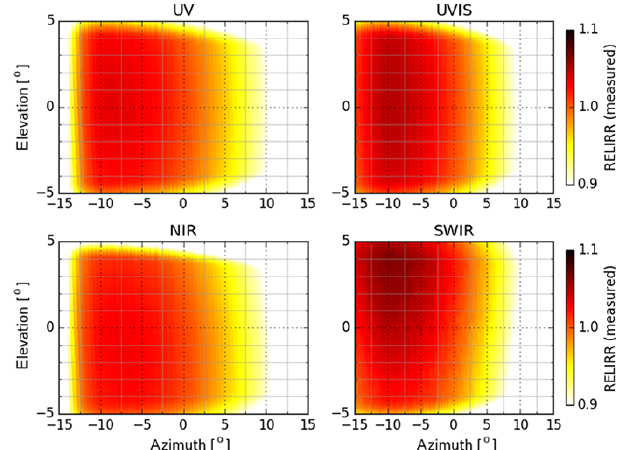
Figure 10. The residuals of the fit shown in Fig. 9. Orbit-to-orbit variations (visible as stripes) form the main